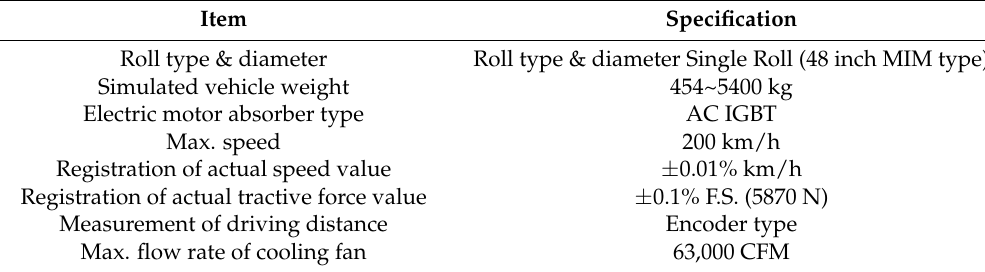
Figure 2. Schematics of the gasoline vehicle emission measurement system. Table 2. Specifications of the chassis dynamometer.